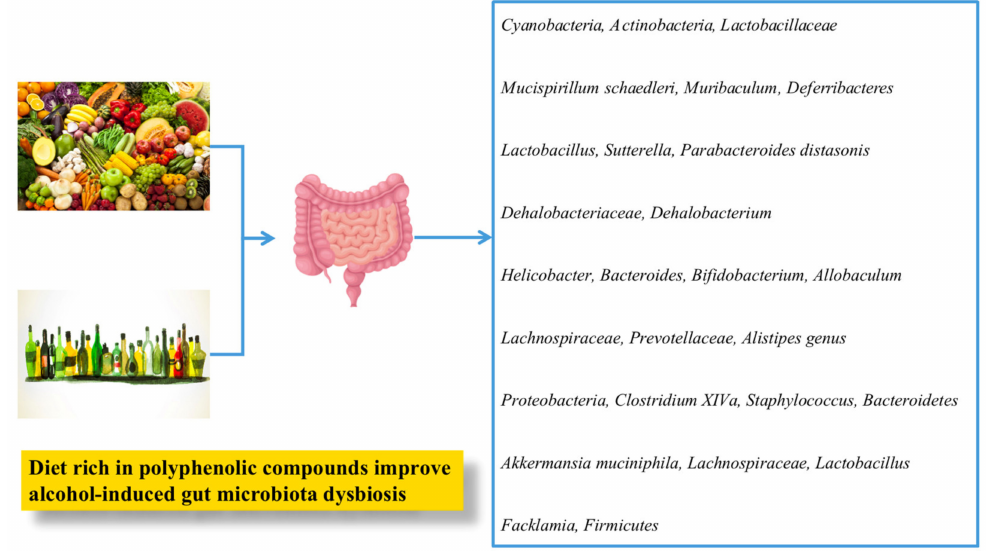
Figure 3. Schematic illustration of effect of edible food plants and bioactive compounds on gut microbiota composition [110,148,158,179,181,190,202–204]. Table 2. Protective effects of various edible food plants against